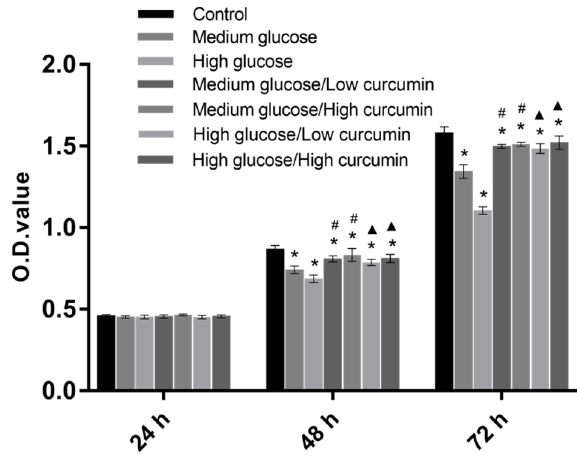
Figure 1. Effects of curcumin on viability of MC3T3 cells in high-glucose conditions. Cell viability was measured using the CCK8 assay after culturing for 24, 48, and 72 h, separately. The bar chart shows the mean optical density (OD) values ( n = 3). * p < 0.05 vs the control group; # p < 0.05 vs the medium glucose group; ▲ p < 0.05 vs the high-glucose group.